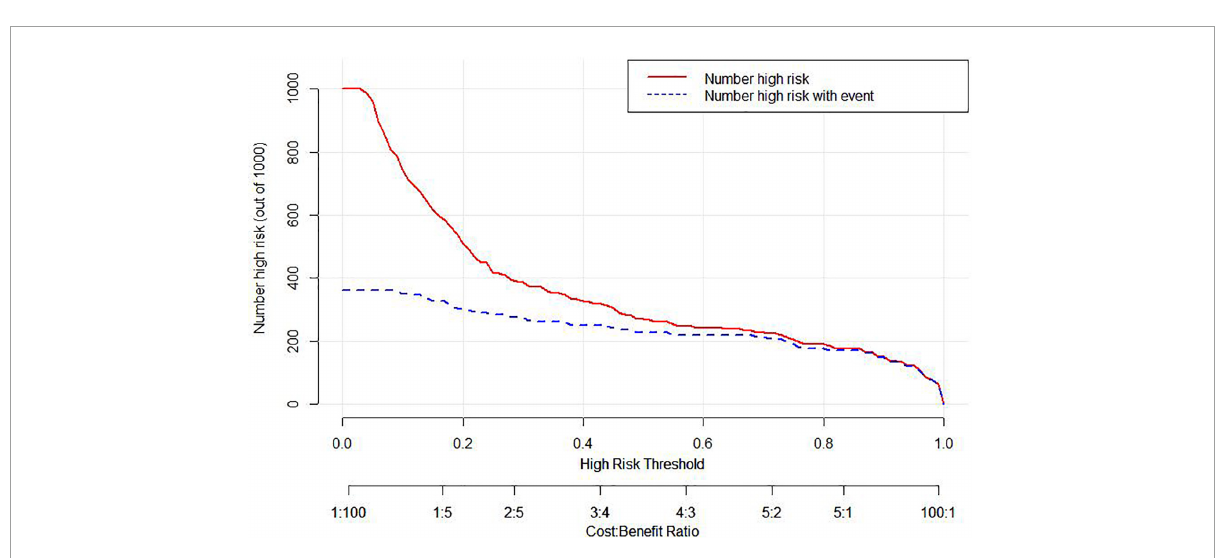
FIGURE6 Clinical impact curve (CIC) of the nomogram. The Number high risk curve indicates the number of patients classified as high risk by the nomogram under each threshold probability. The Number high risk with event curve stands for actual numbers under each threshold